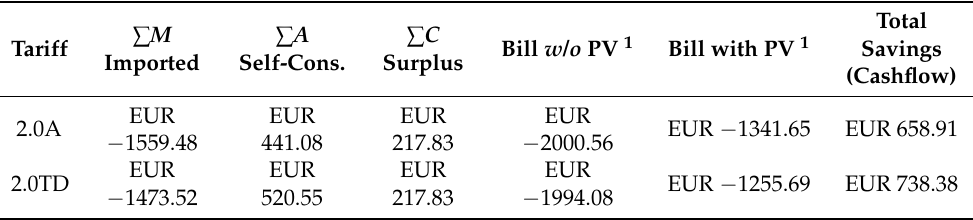
Table 2. Economic performance of the PVSCS for a full year (August 2020 to July 2021) comparing the former tariff 2.0A and with the new 2.0TD tariff. Taxes are